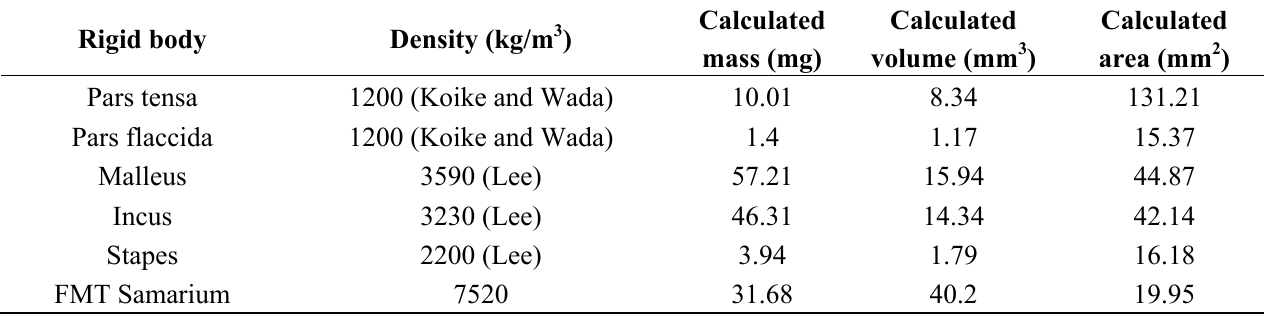
Table 1. Parameters of the rigid bodies constituting the MBS of the middle ear model and the floating mass transducer (FMT).